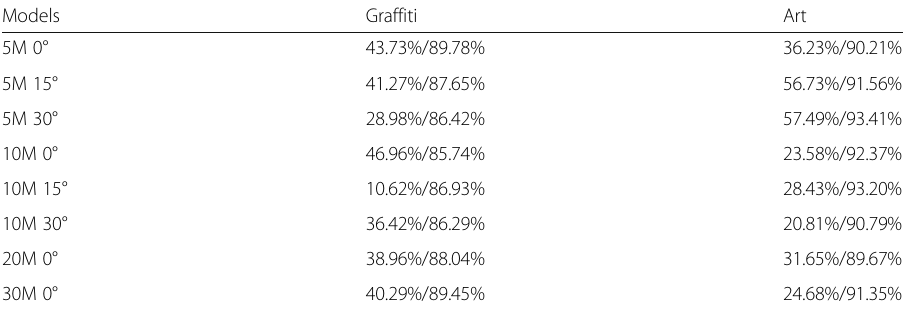
Table 3 Top 1 classification accuracy under the graffiti attack and art attacks scenario (%) Models